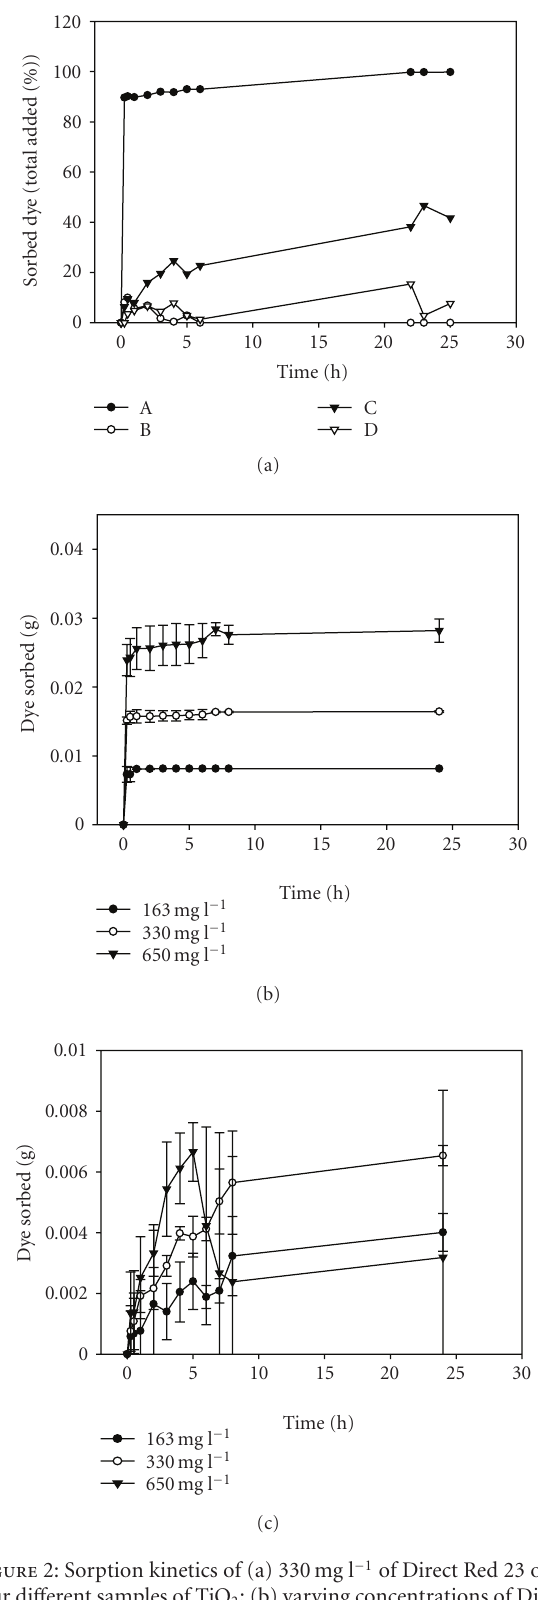
Figure 2: Sorption kinetics of (a) 330 mg l − 1 of Direct Red 23 onto four di ff erent samples of TiO 2 ; (b) varying concentrations of Direct Red 23 onto TiO 2 sample A; (c) varying concentrations of Direct Red 23 onto TiO 2 sample C. Error bars are omitted from (a) for